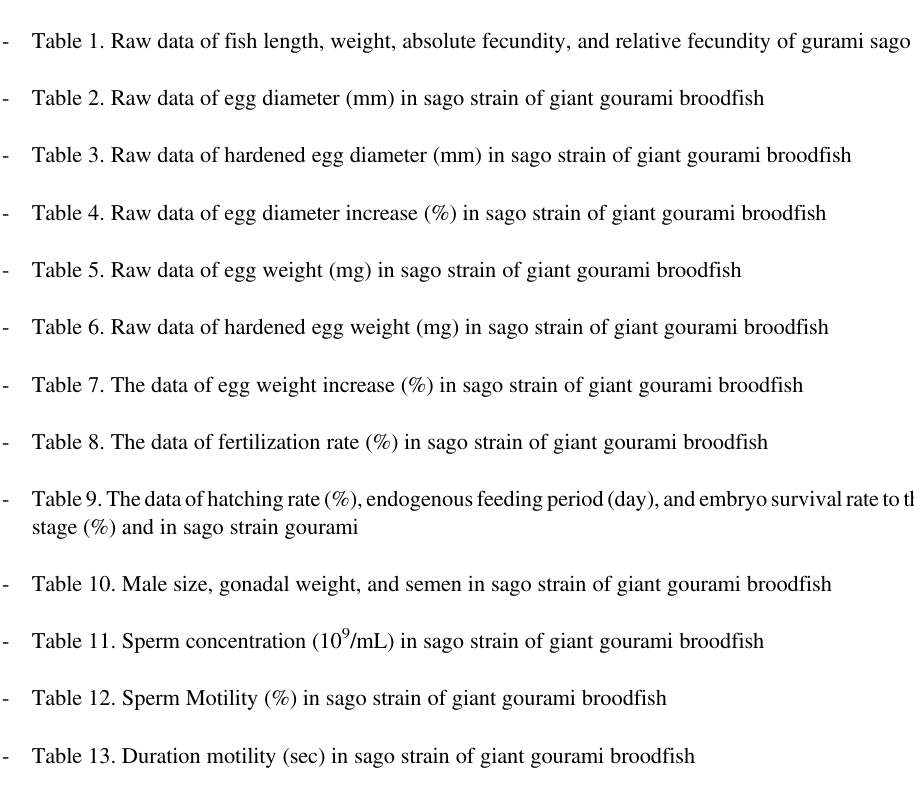
- Table 13. Duration motility (sec) in sago strain of giant gourami